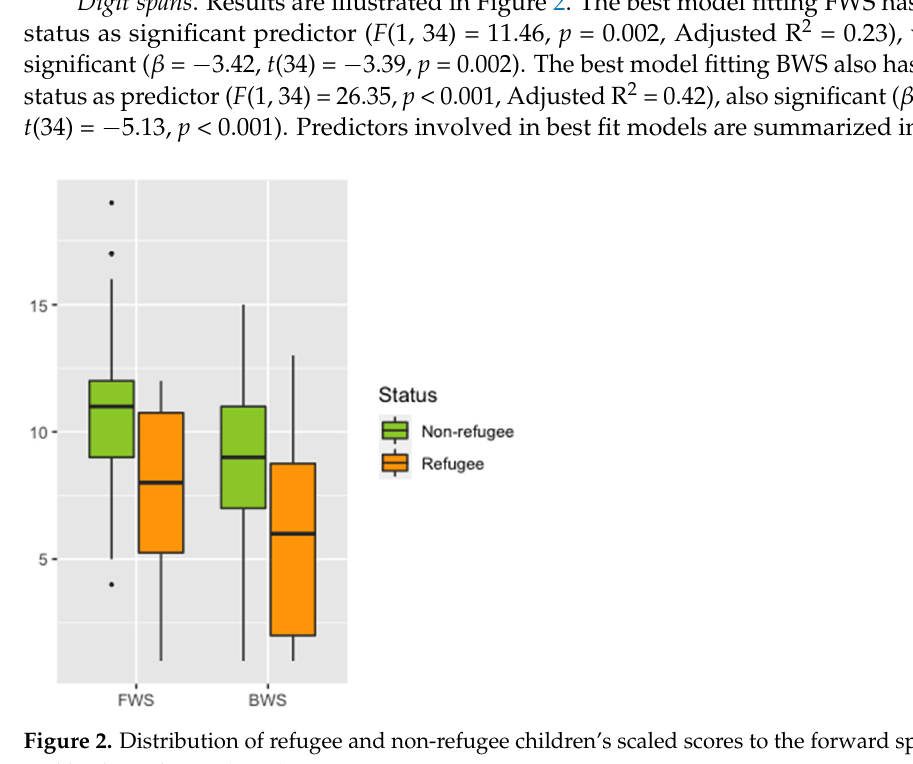
Figure 2. Distribution of refugee and non-refugee children’s scaled scores to the forward span (FWS) and backward span